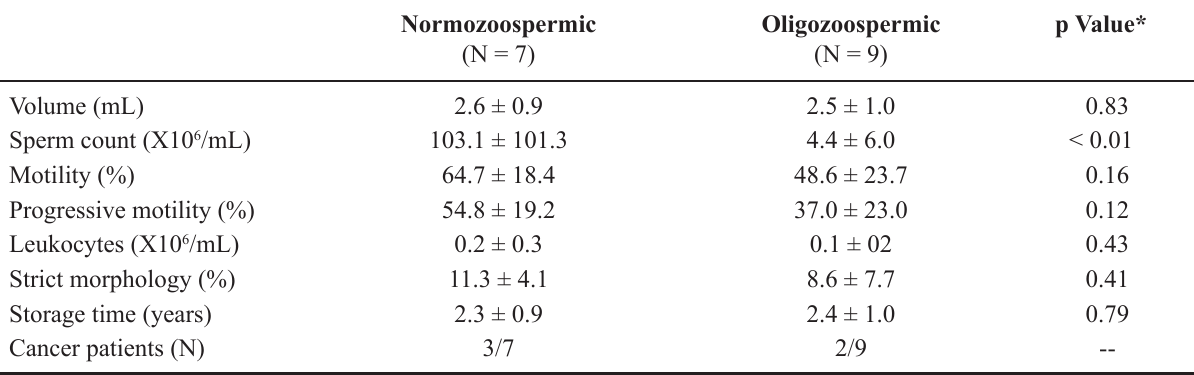
Table 1 – Pre-freeze sperm parameters, length of time samples remained in storage prior to use and number of cancer patients in each group of normozoospermic and oligozoospermic sperm specimens. Values are mean ±